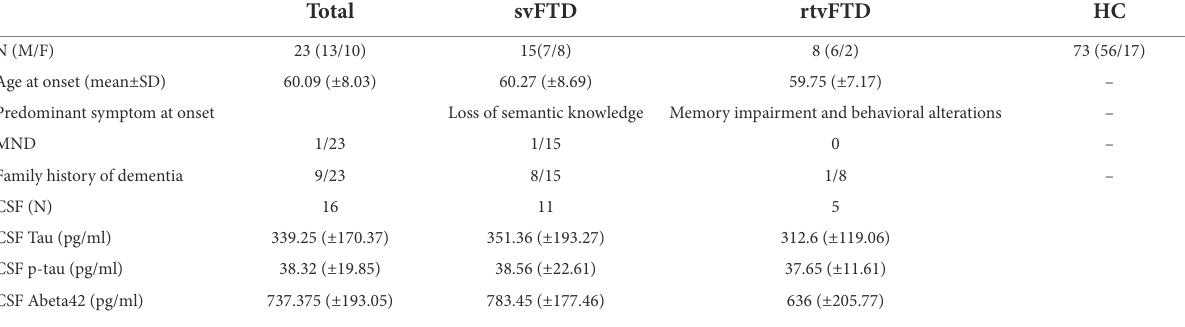
TABLE 1 Clinical and demographic features of study